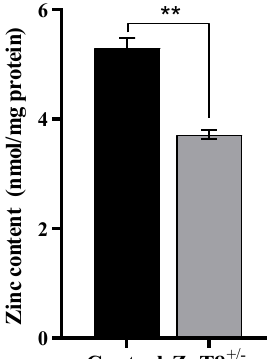
Figure 3. Zinc content of ZnT8 haploinsufficient MIN6 cells. Total cellular zinc content was determined through ICP-MS and normalised to protein. Experiments were carried out at 48 h. Data were analysed by 2-way ANOVA followed by Tukey’s multiple comparison test. n = 4. ** p < 0.005.